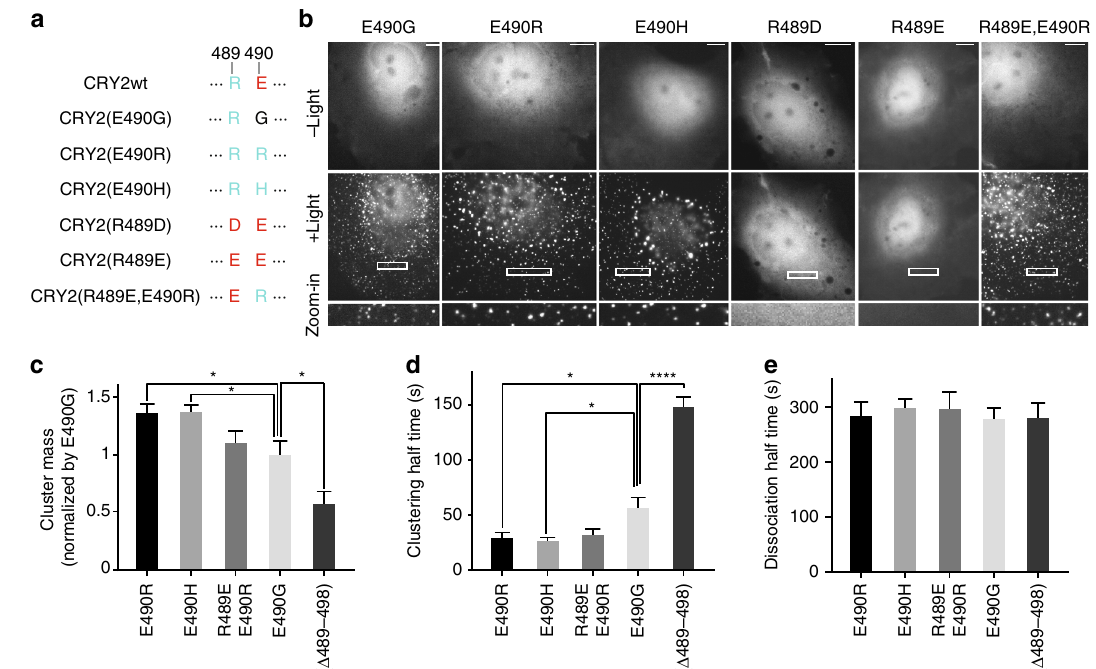
Fig. 2 Double-positive charges at residues 489 and 490 enhance CRY2 homo-oligomerization. a A series of mutations were introduced at positions 489 and 490 of CRY2. b Cytosolic CRY2(R489D) and CRY2(R489E) did not form noticeable clusters, while the other mutants oligomerized into clusters drastically. Blue light was delivered at 5-s intervals for a total of 500 s. c The cluster mass was quanti fi ed using a custom Matlab program and normalized against that of CRY2(E490G). d Half-maximal clustering time of each CRY2 variant. e Dissociation half time of each CRY2 variant. Results are presented as means ± s.e.m. ( n = 13, 12, 14, 21, 14). Results were analyzed using one-way ANOVA with Dunnett ’ s post hoc test. (* P < 0.05, **** P = 0.0001). Scale bars